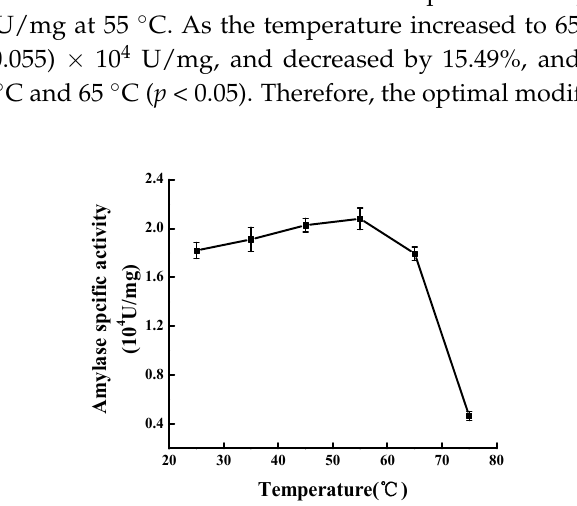
Figure 2. Effect of the molar ratio of SPA to Mal-mPEG5000 on SPA activity.